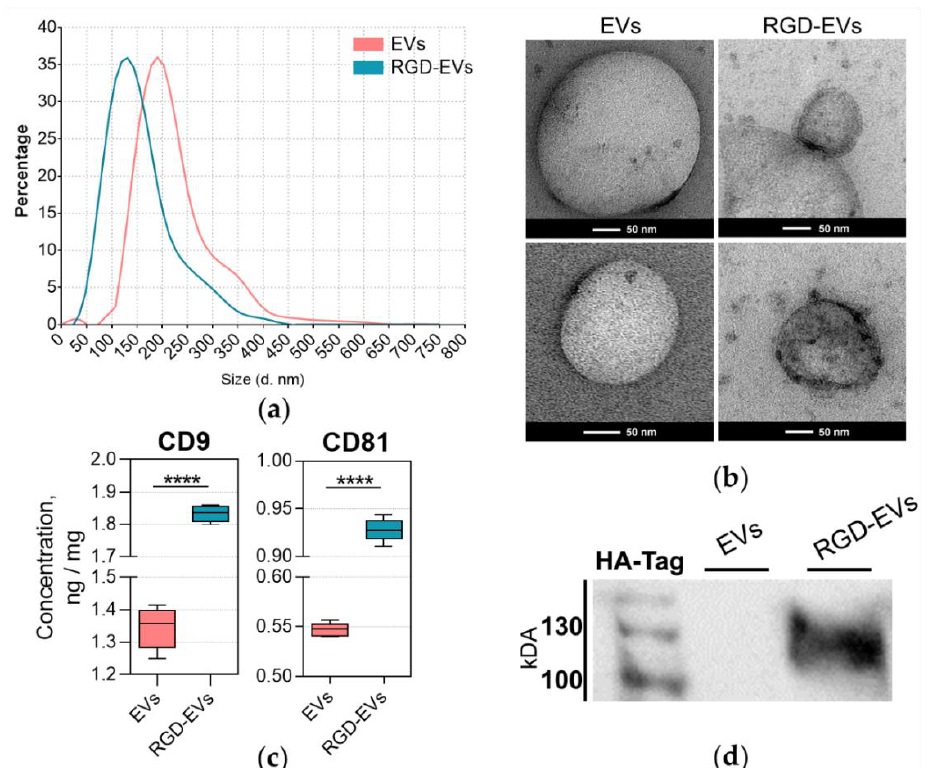
Figure 2. Characteristics of parental HEK 293FT and modified RGD-HEK 293FT EVs. ( a ) NTA results. The graphs show particle sizes ranging from 50 to 450 nm, with peaks of 120 for RGD-EVs and 180 nm for native EVs. ( b ) Representative TEM images. ( c ) ELISA confirmed the presence of tetraspanins CD9 and CD81 detected in EV isolates in HEK 293FT- and RGD-HEK 293FT-cell-conditioned media; **** p < 0.0001. ( d ) The Lamp2b-RGD-HA protein can be observed abundantly in the Western blot of RGD-EV particle samples but are absent in native EVs. Full blot images provided in Appendix A, Figure A2.